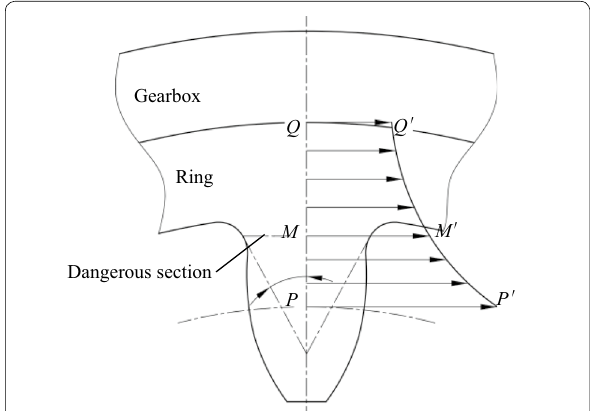
Figure 1 The theoretical curves of the